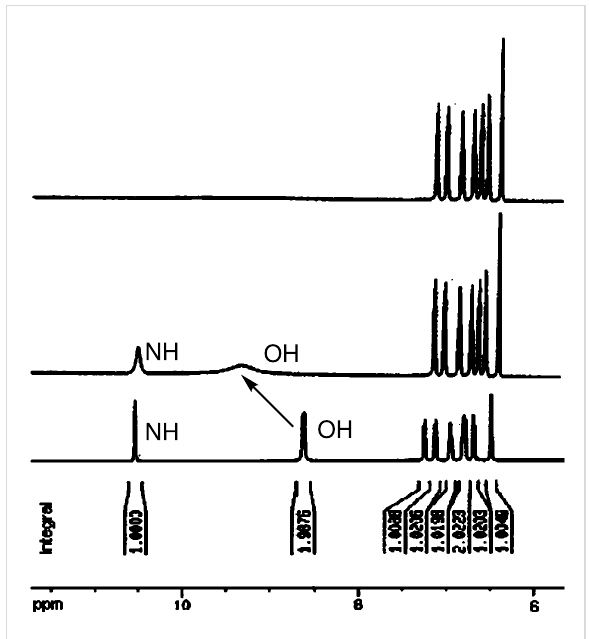
Figure 8: 1 H NMR spectra of receptor 1 (bottom), 1 with [Bu 4 N] + F − 1:2 [receptor 1 :(Bu 4 N) + F − ] (middle) and excess [Bu 4 N] + F −